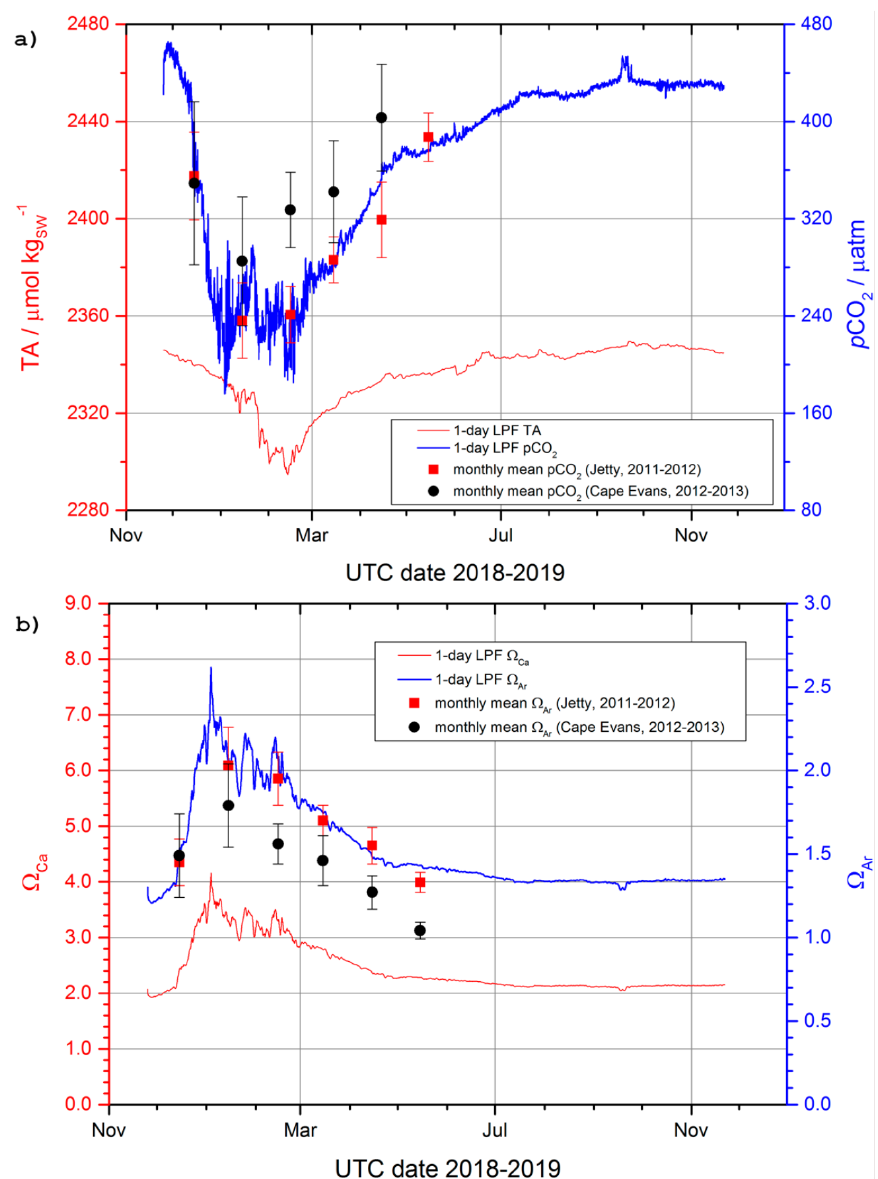
Figure 9. Annual trend in calculated total alkalinity (TA) and p CO 2 ( a ) and Ω Ca and Ω Ar ( b ) in Terra Nova Bay between November 2018 and November 2019. Original data are compared with values reported in literature [46] for two near-shore sites close to McMurdo Sound, Jetty (squares) (2011–2012) and Cape Evans (circles) (2012–2013). The trend of p CO 2 was comparable to that of TA (Figure 9a), with minimum peaks recorded in February 2019 ( p CO 2 : 240 ± 21 µ atm; TA: 2305 ± 5 µ mol kg SW − 1 ), but was in contrast to the measured pH T trend (max pH T : 8.24 ± 0.03; Figure 4a). Monthly mean calculated p CO 2 values ranged between 240 and 435 µ atm. The highest values (greater